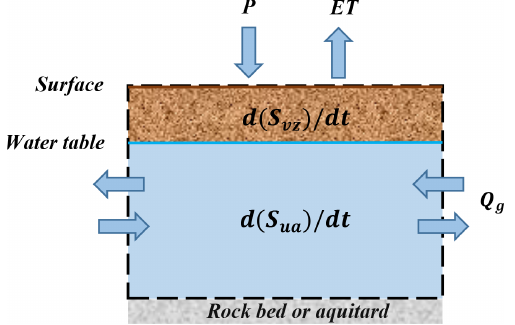
Figure 1. Conceptual model of groundwater balance over a control volume (after Maxwell, 2010). P is precipitation, ET is actual evap- otranspiration, Q g is the lateral groundwater flow, S vz and S ua are the water storages in the vadose zone and the unconfined aquifer, respectively, and t is